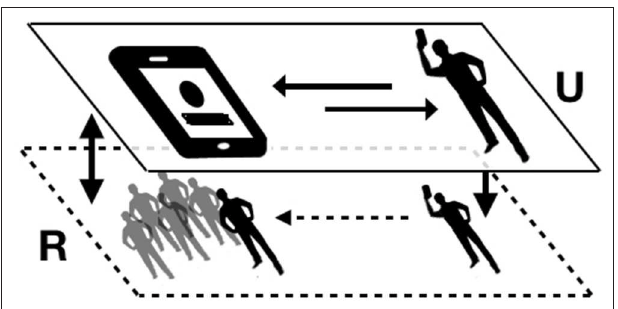
FIGURE 2 | A duplex model of non-verbal communication in selfies. Self-presentation by a user (U) is communicated to single or multiple recipients (R) through the interplay (double arrow) of two layers of interaction: a primary human-media interaction (solid lines) and a secondary human-human interaction (dashed lines). The human-media interaction is primary in that it can be controlled directly by the user; it can be conceived as a form of sensorimotor exploratory behavior (arrows pointing in both directions) of one’s appearance in the smartphone preview screen. The human-human interaction is secondary in that it requires tools to preserve information over space and time; it is a form of indirect communication (dashed arrow) between the user and the